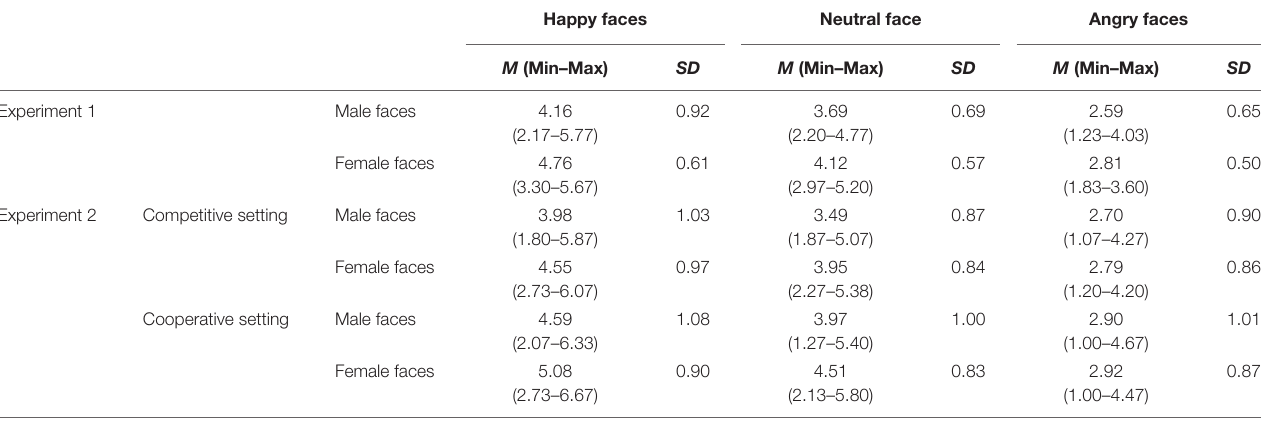
TABLE 1 | Descriptive statistics for the trustworthiness ratings of male and female faces with different expressions in Experiment 1 and 2, the numbers in the parentheses under the mean value are the min and max values the participants rated in each condition. Happy faces